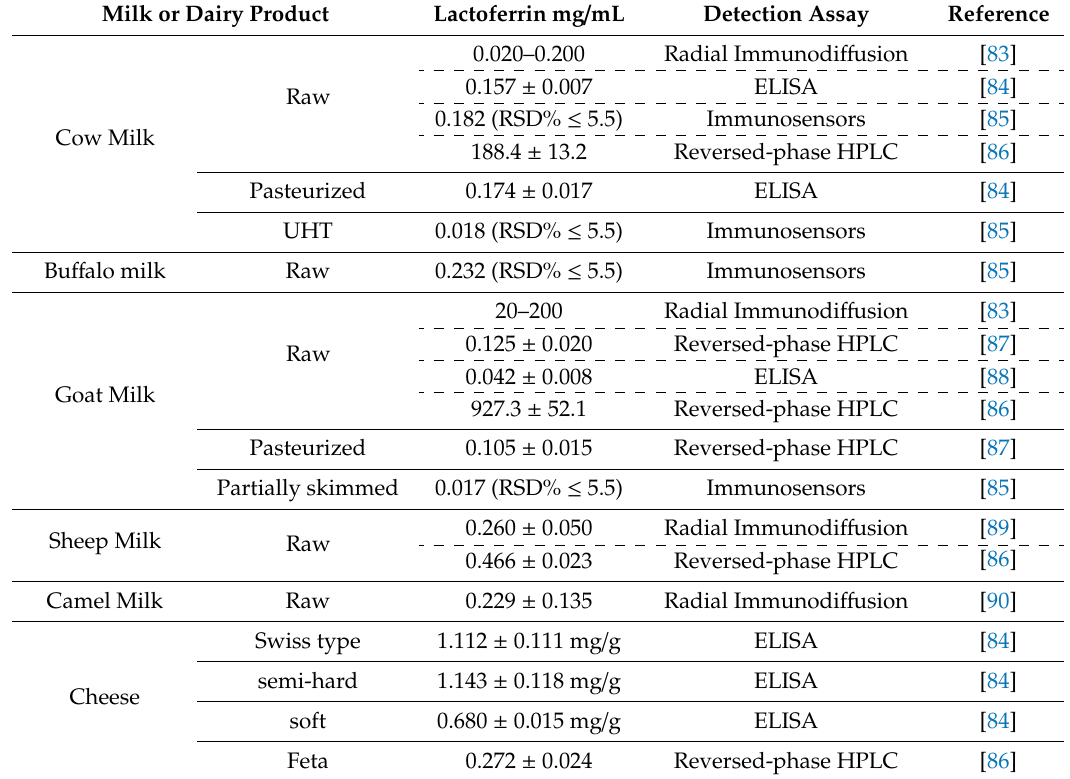
Table 1. Lactoferrin concentration in milk and dairy products from di ff erent